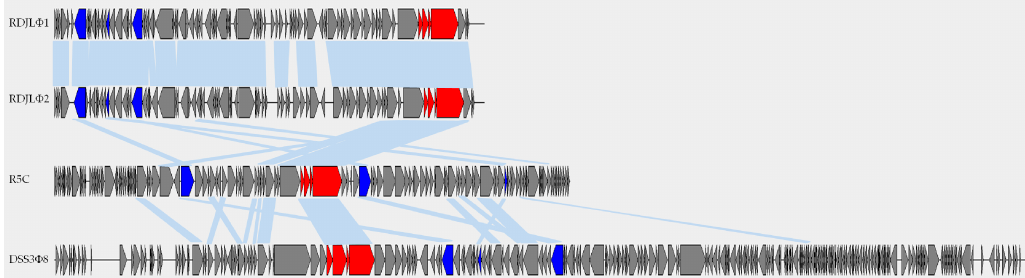
Figure 4. Comparison of four roseophages that possess GTA genes. Four GTA genes are indicated in red and other three conserved shared genes are indicated in blue. Genes sharing amino acid similarity between two phages are connected by light blue lines (E-value < 10 − 3 ).